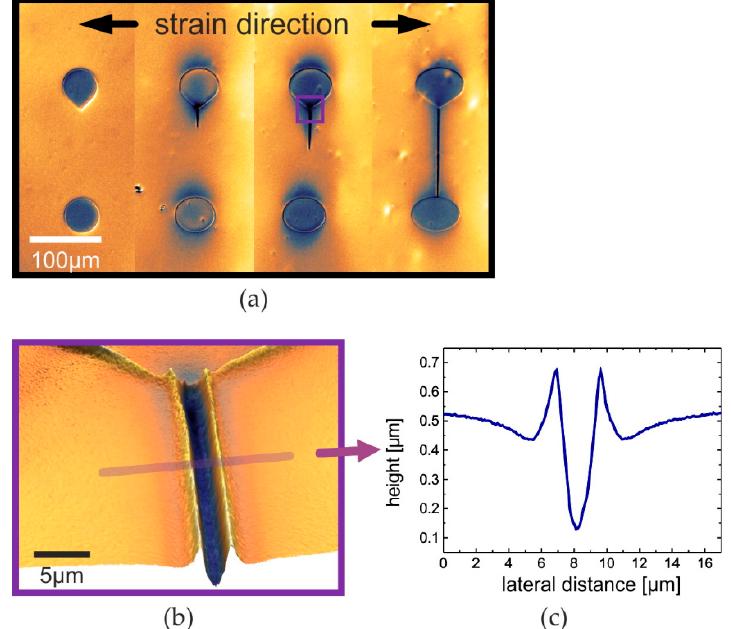
Figure 1. The idea of controlled cracking. Surface profiles from white light interferometry of soft islands on a hardened PDMS surface under various strain; ( a ) increasing strain (left to right) leads to controlled cracking at the tip of the upper island and crack tip propagation towards the bottom island until the crack is fully stabilized (right); and ( b ) a controlled crack with ( c ) the corresponding height profile.